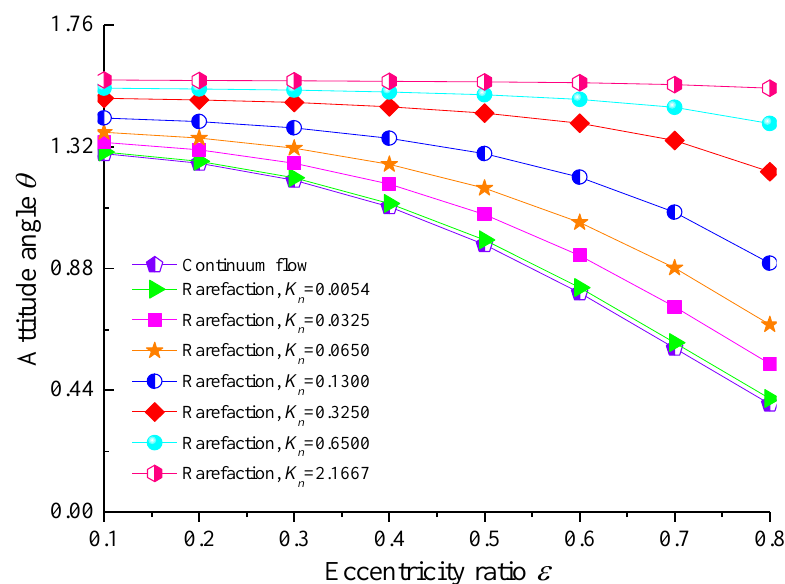
Figure 5. The attitude angle of Boltzmann model versus eccentricity ratio for different Knudsen numbers ( Λ = 3, B / D = 0.5).